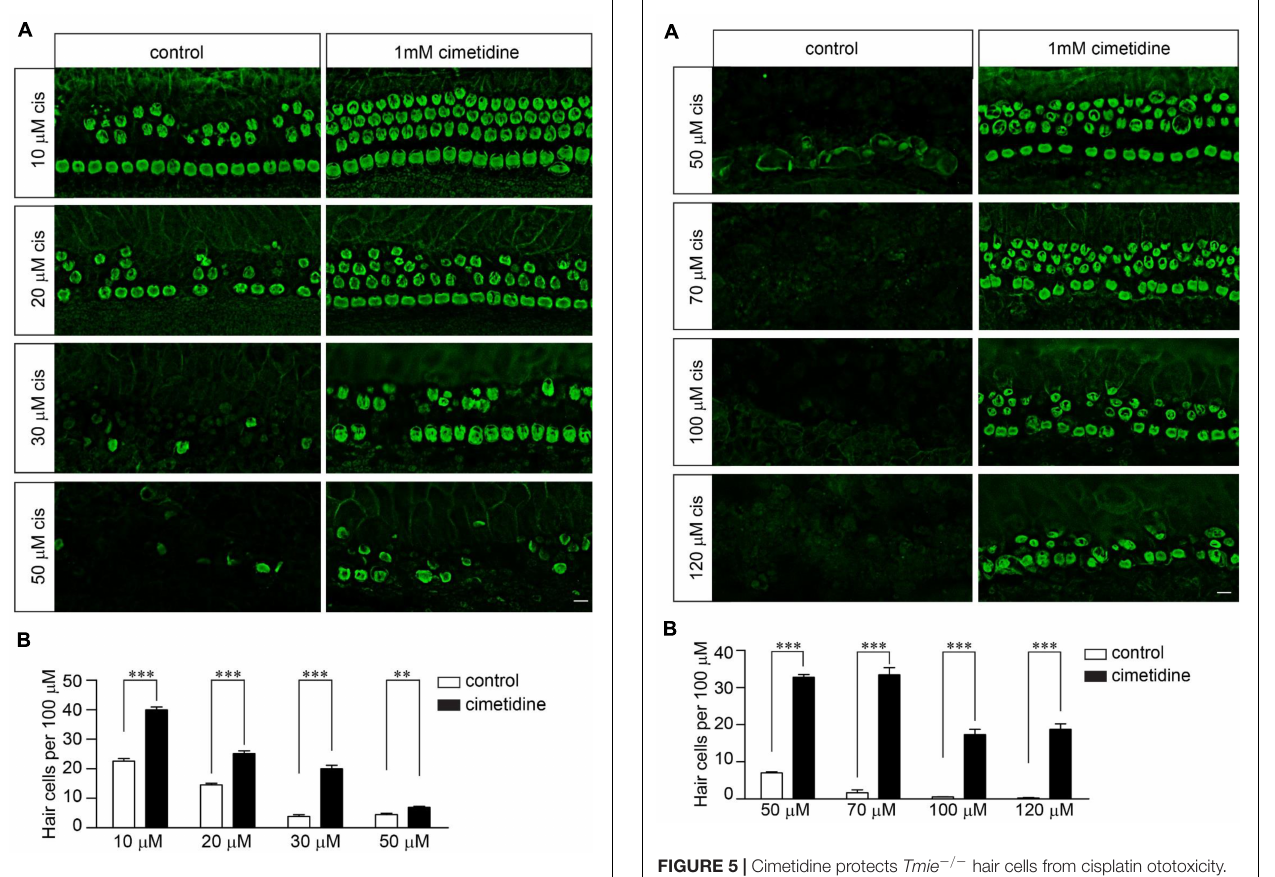
of additional entry routes of cisplatin into murine hair